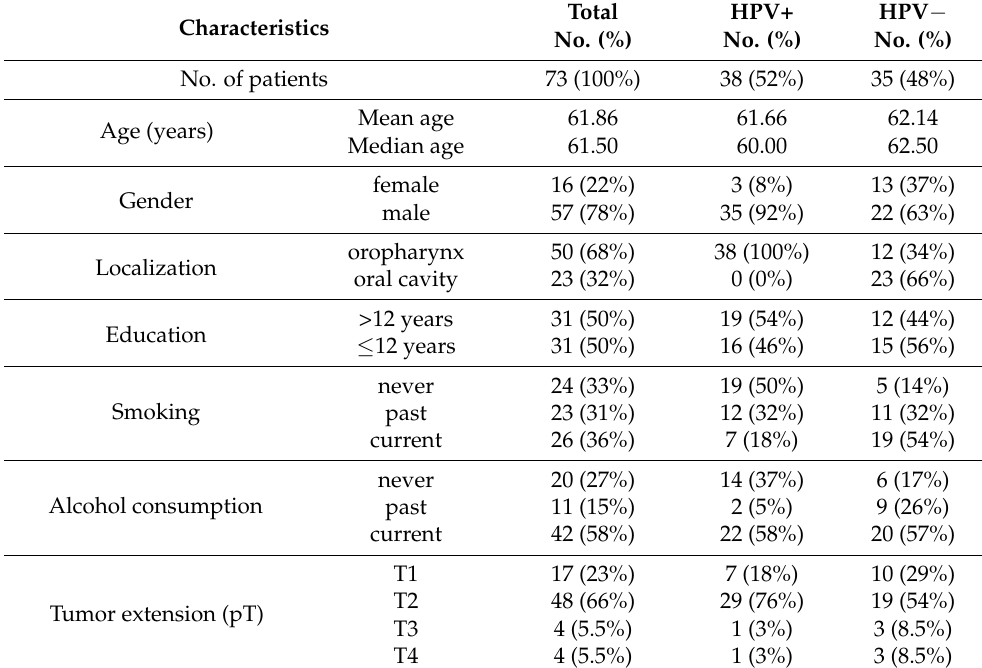
Table 3. Demographic and clinical characterization of the